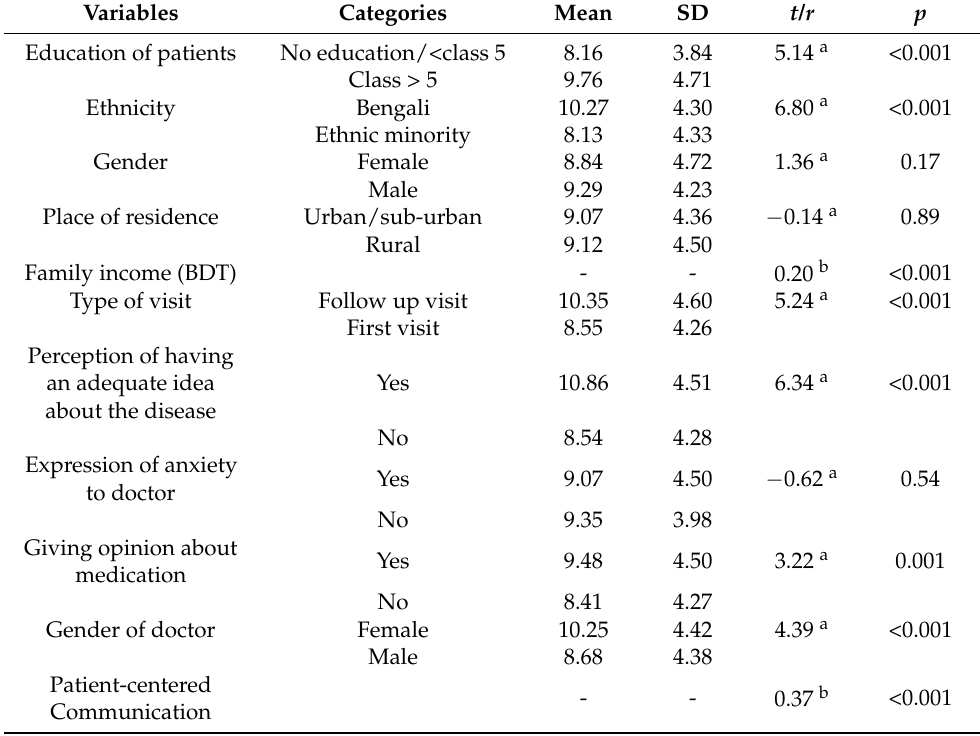
Table 2. Patients’ socio-demographic, cognitive and predisposing predictors and doctors’ predispos- ing predictors of longer appointment length in medical